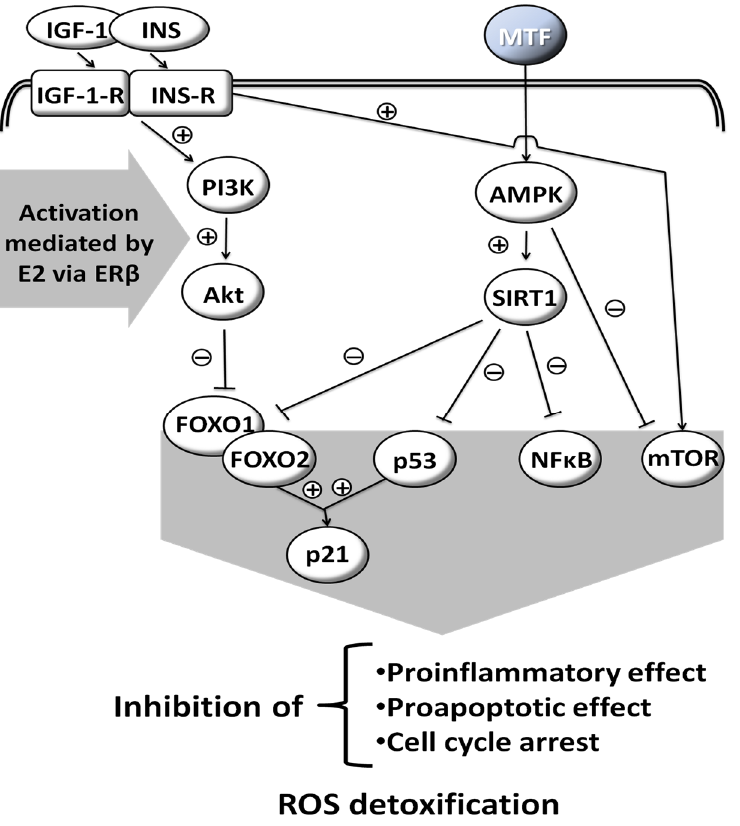
Figure 1. Molecular responses that are elicited by MTF; some are influenced by sex hormones. In- sulin-like Growth Factor-1, INS: Insulin, IGF-1-R: Insulin-like Growth Factor-1-Receptor, INS-R: Insulin Receptor, PI3K: Phosphoinositide 3-kinase, Akt: Serine/threonine protein kinase B, AMPK: AMP-activated protein kinase, SIRT1: Sirtuin 1, FOXO1: Forkhead box protein O1, FOXO2: Forkhead box protein O2, p53: Tumor protein p53, NF κ B: Nuclear factor kappa-light-chain-enhancer of activated B cells, mTOR: Mammalian target of rapamycin, p21: Cyclin-dependent kinase inhibitor 1, ROS: Reactive oxygen species, E2: Estradiol, ER β : Estrogen receptor β , (+): activation, ( − ): inhibition, drawn with data from [10–13] .